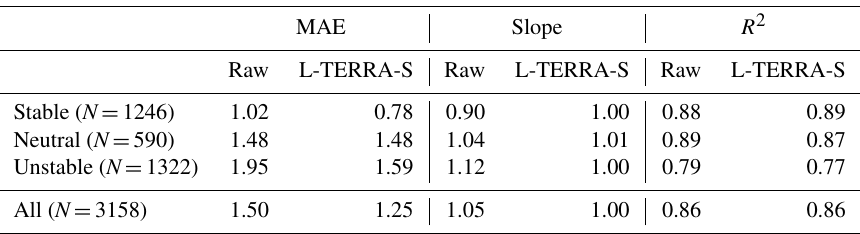
Table 3. Mean absolute error (MAE) and slope and R 2 values of regression lines for WC TI compared to met tower TI before and after L-TERRA-S has been applied for the 60m measurement height at the ARM site. MAE Slope R 2 Raw L-TERRA-S Raw L-TERRA-S Raw L-TERRA-S Stable ( N =